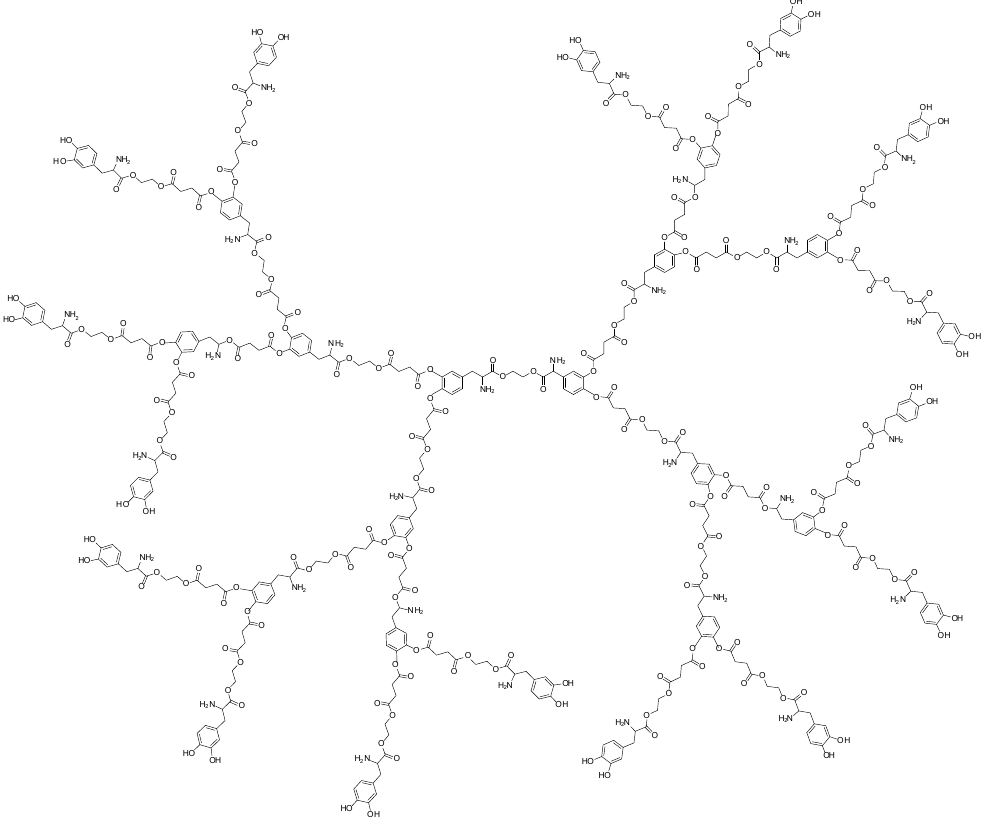
Figure 21. Dendrimer prodrug designed with L -dopa [15].